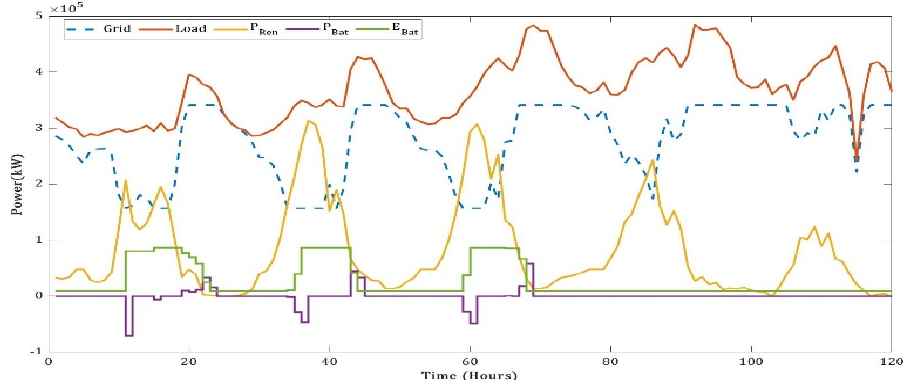
Figure 17. Power distribution with ALA-QPSO for the minimum LCoE for 21–26 June.